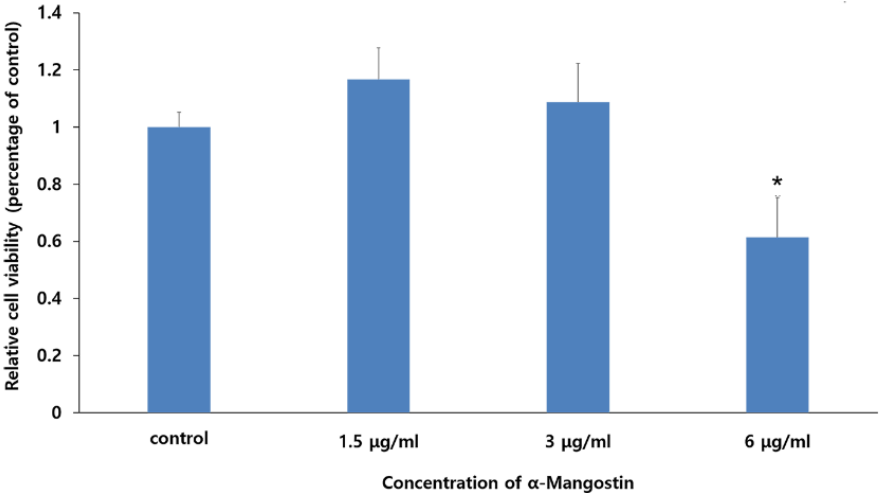
Figure 1. The effect of α -MG on the viability of hDPCs. Results are expressed as relative cell viabilities depending on the different concentrations of α -MG. Cell viability significantly decreased in the 6 µ g/mL α -MG treated group (* p < 0.05 compared to the control group).